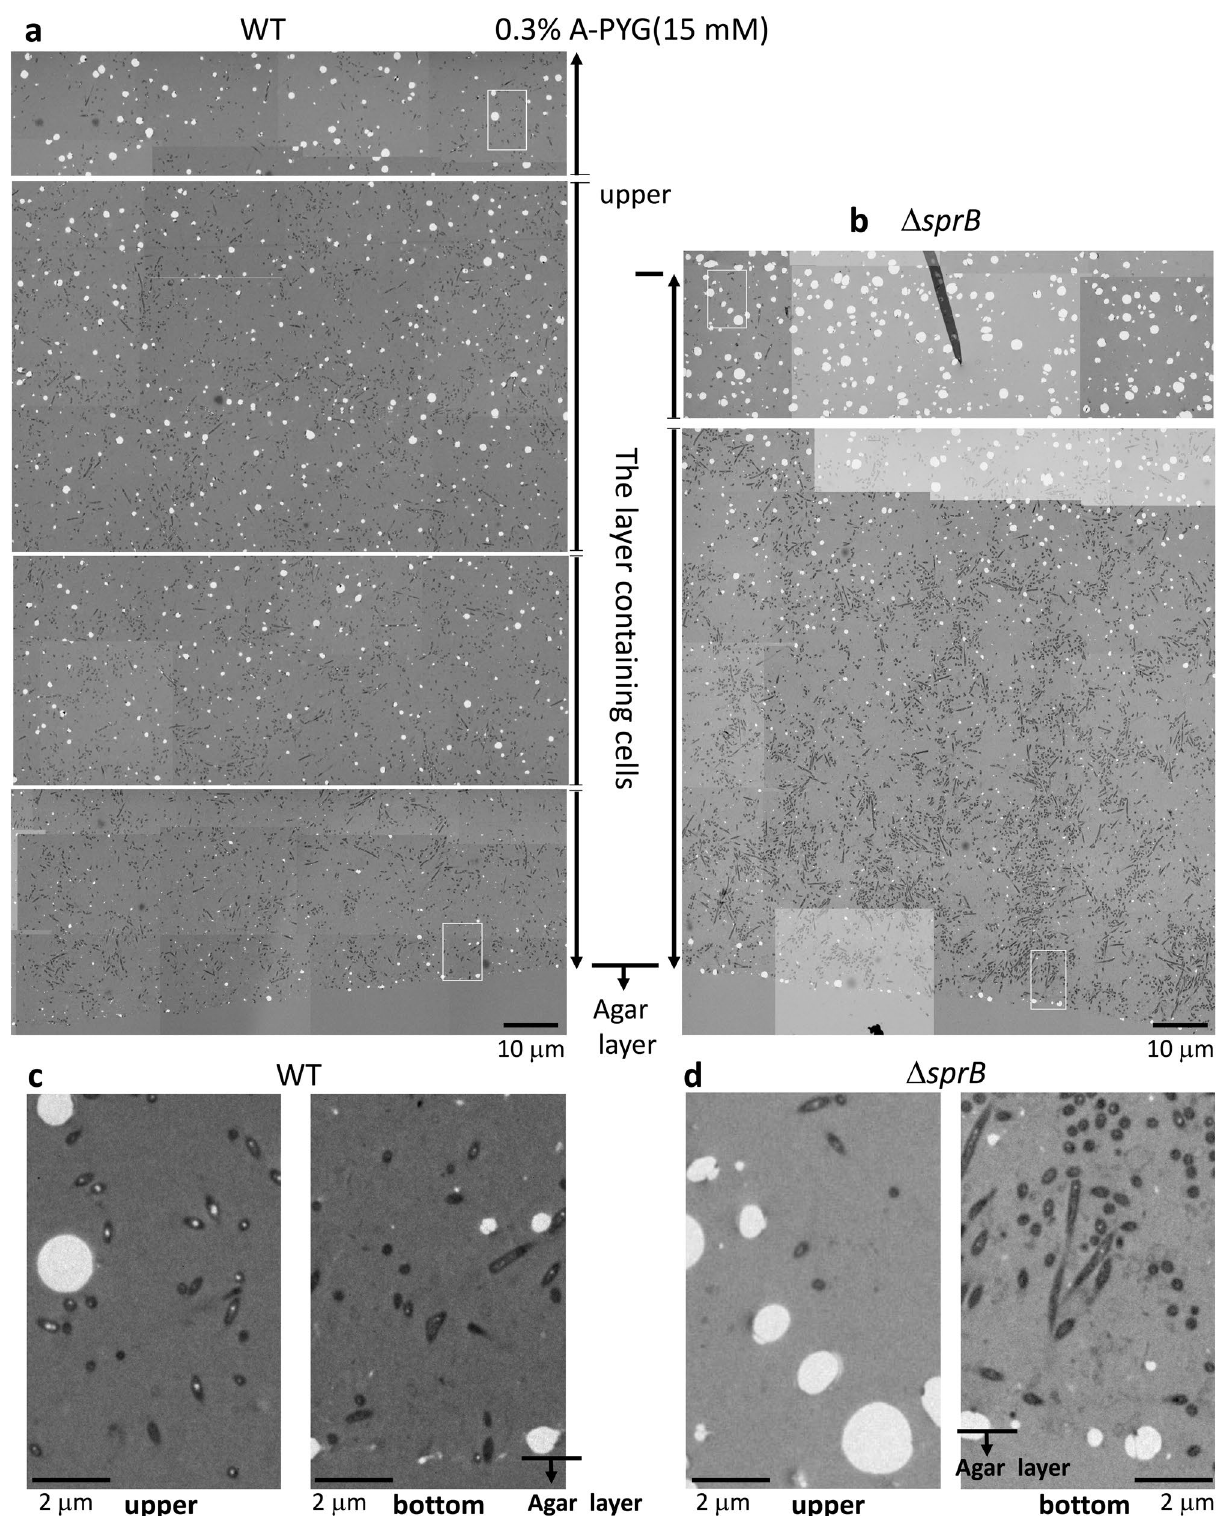
Figure 3. TEM of WT and Δ sprB mutant F. johnsoniae spreading colonies on 0.3% A-PYG (15 mM). ( a–d ) Colonies were embedded in Epon resin, sliced into 70-nm sections, and observed by TEM. Sections of WT ( a ) and Δ sprB ( b ) colonies are shown. The cells were interspersed within the intercellular matrix. ( c,d ) High magnification images of a WT colony ( c ) and a Δ sprB colony ( d ). In both cases, the left and right panels are images of the upper and lower regions of the spreading colony,